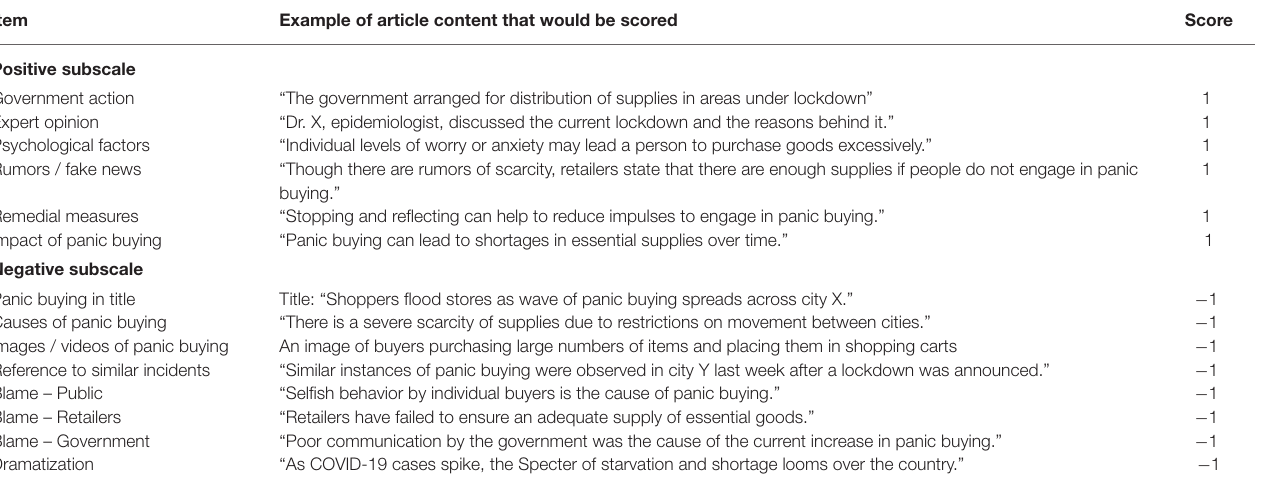
TABLE 3 | Sample analysis of news articles using the Arafat et al. guidelines. Item Example of article content that would be